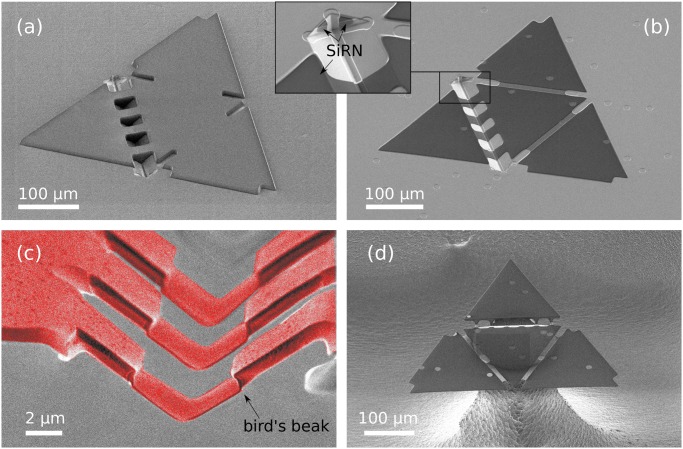
SEM images of final fabrications steps.(a): Tetrahedral pattern of thick photoresist. (b): SiRN template after over-etching in the grooves and stripping of photoresist. The combination of a complex hinge with two flat hinges can be observed, see Fig 5(a). (c): Close-up image of a complex hinge after the silicon mold was etched away in dry etching and the photoresist stripped, Fig 4(k). (d): Overview of an unfolded tetrahedral structure at the end of the process. Isotropic etching of Si is stopped once the pattern comes to rest on a central pillar, Fig 5(b). Note that this structure is not completely released, since Si is still present under the flaps.